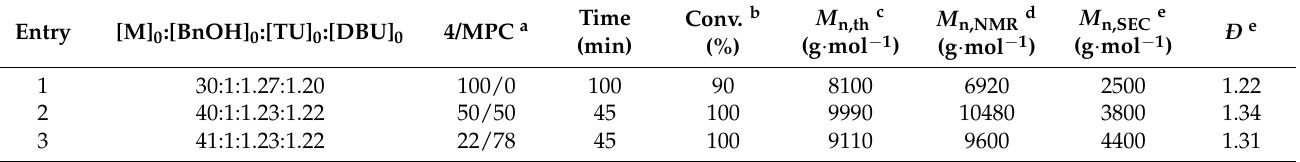
Table 1. Summary of ROP of 4 and its copolymerization with MPC monomer using TU/DBU. [M] 0 :[BnOH] 0 :[TU] 0 :[DBU]